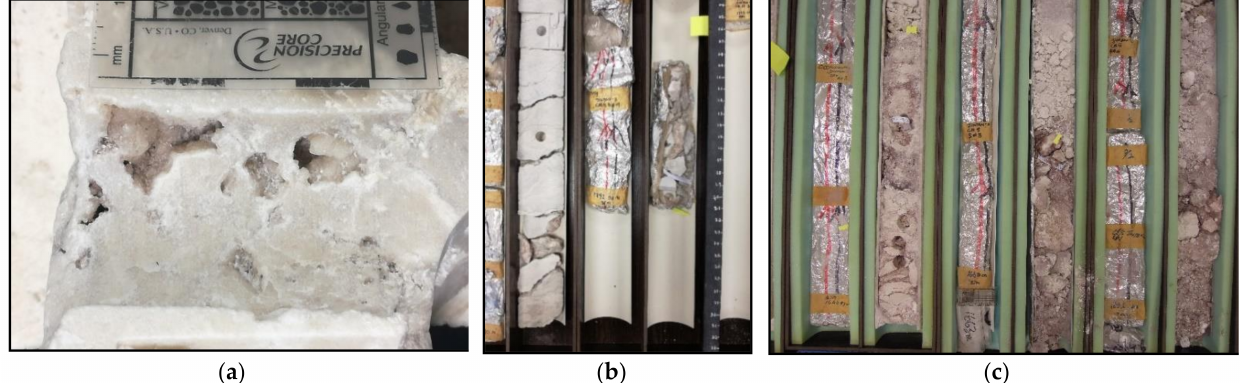
Figure 13. ( a ) Chalkified intervals observed in Jintan-2 well between 1662.97–1664.6 m depth ( b ) Rubble core observed in Jintan-3 well at 1792.4–1791 m depth ( c ) ≥ 0.5–1 cm large vugs and moldic porosity observed in Jintan-3 well at 1672.5 m